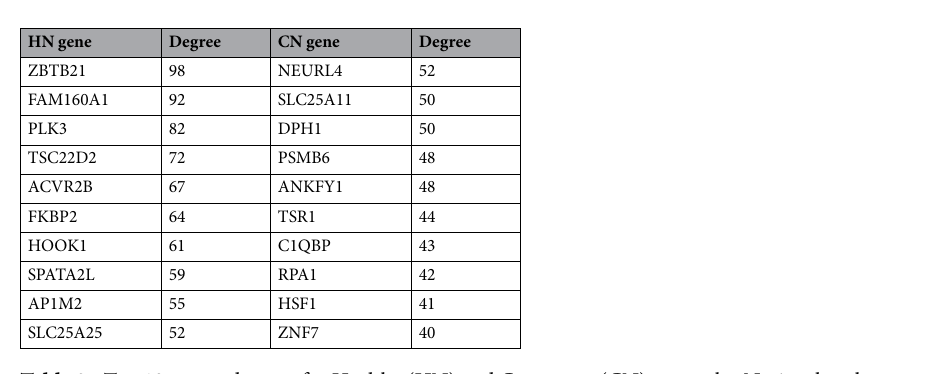
Table 2. Top 10 vertex degrees for Healthy (HN) and Cancerous (CN) networks. Notice that the more connected gene in CN (NEURL4) has the same number of neighbours than the tenth highest degree node in HN